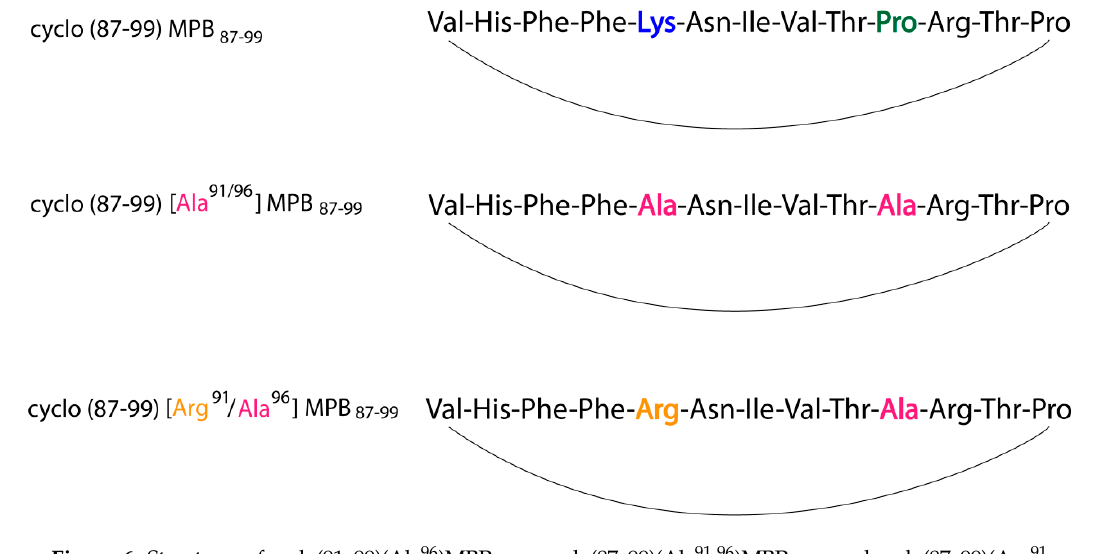
Figure 6. Structures of cyclo(91–99)(Ala 96 )MBP 87–99 , cyclo(87–99)(Ala 91 , 96 )MBP 87–99 and cyclo(87– 99)(Arg 91 , Ala 96 )MBP 87–99 .